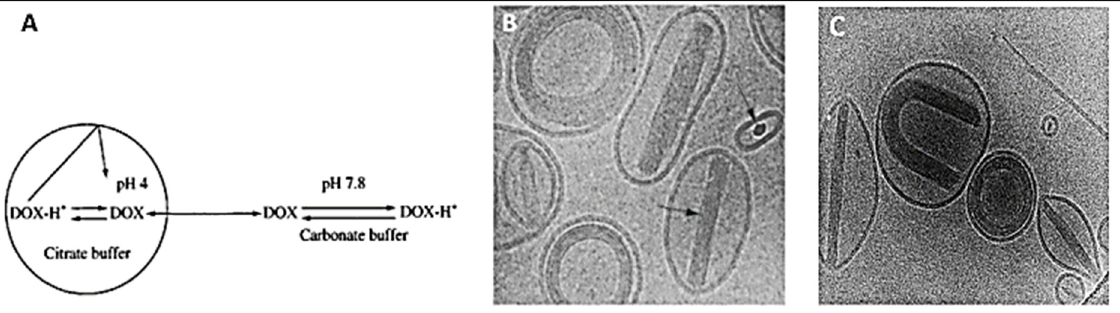
Figure 6. ( A ) DOX loading via citrate transmembrane gradient method, ( B , C ) confocal images of DOX-loaded liposomes showing the coffee-beans liposomes appearance where DOX-citrate complexes appear in rod, circular and U-shaped structures. A , B are adapted with permission from [50], Elsevier, 2001. C is adapted with permission from [51], Elsevier, 1998.